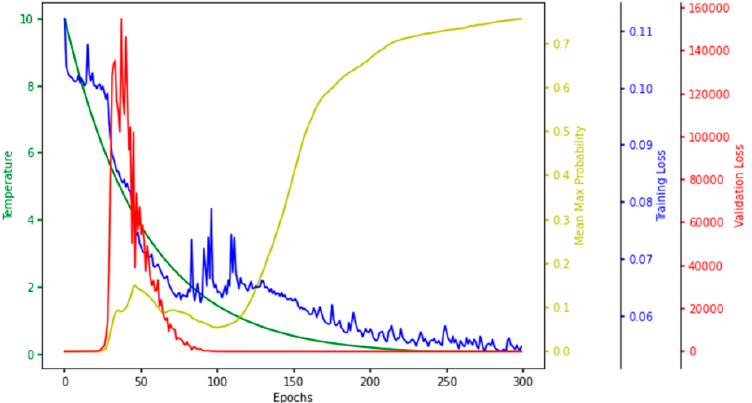
Figure 8. Characteristic Plot of Concrete Autoencoder. Temperature (green), mean–max probability (yellow), training loss (blue), and validation loss (red) are plotted at different scales.